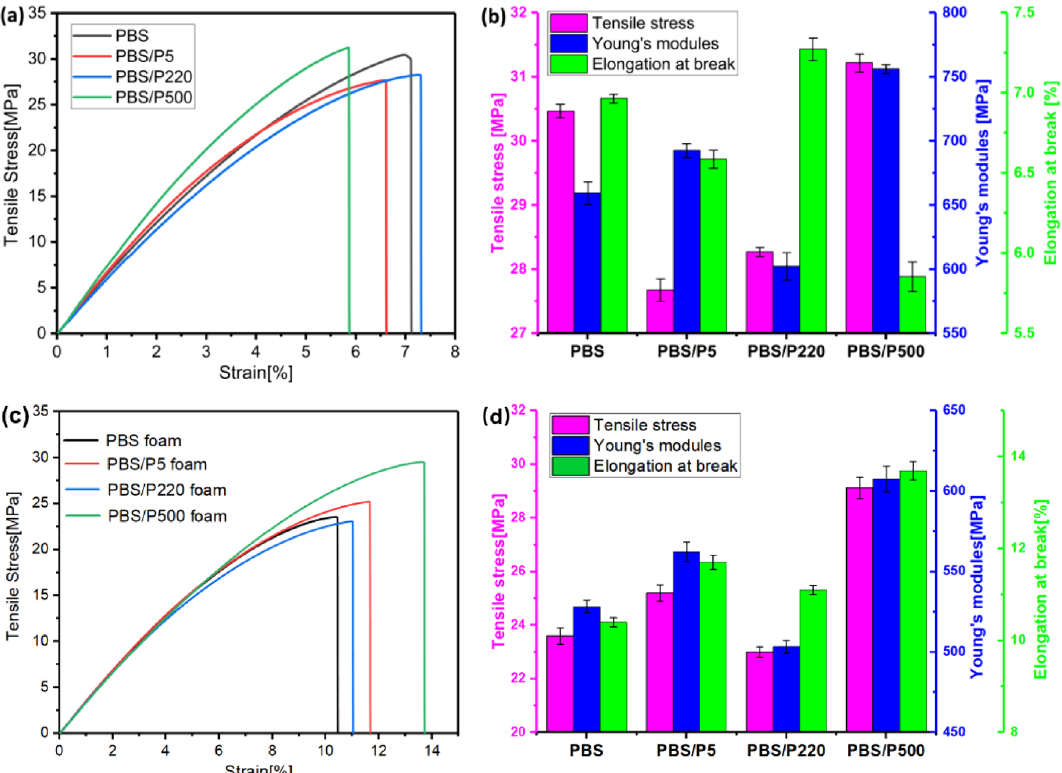
Figure 9. ( a , c ) are tensile stress–strain curves; ( b , d ) are histograms of the Young’s modulus, tensile stress and elongation at the break of solid and foamed PBS and PBS/PTFE